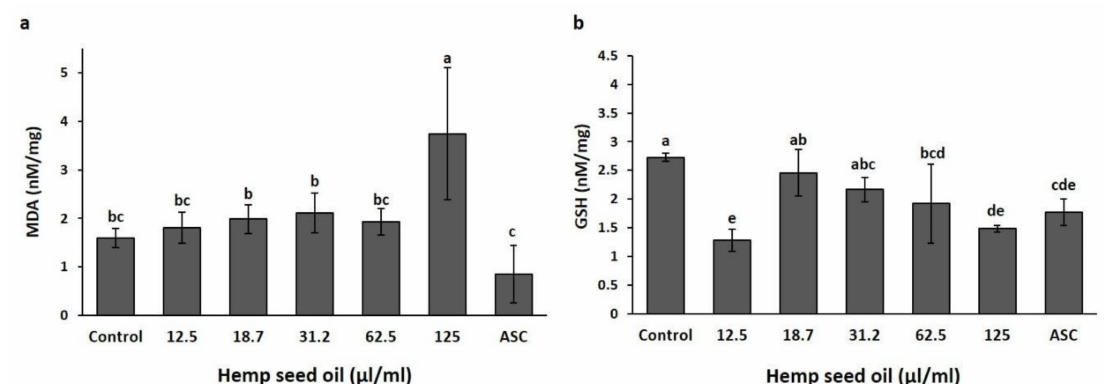
Figure 1. Effects of hemp seed oil on malondialdehyde (MDA) ( a ) and glutathione (GSH) ( b ) contents in D. melanogaster larvae. The hemp seed oil was applied to the feeding medium at six concentrations (0 (control), 12.5, 18.7, 31.2, 62.5, and 125 µ L/mL) compared to a positive control of the antioxidant ascorbic acid (ASC). The results are means ± SD. Different letters above the means represent significant difference between treatments based on LSD test ( p < 0